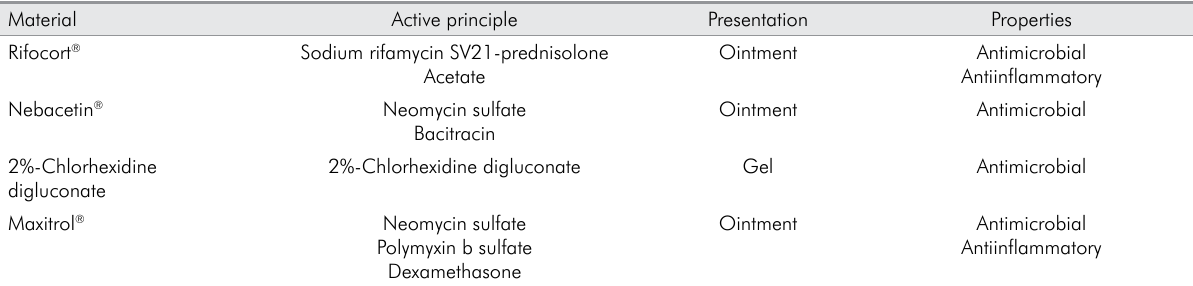
Table 1. Different properties of each material. Material Active